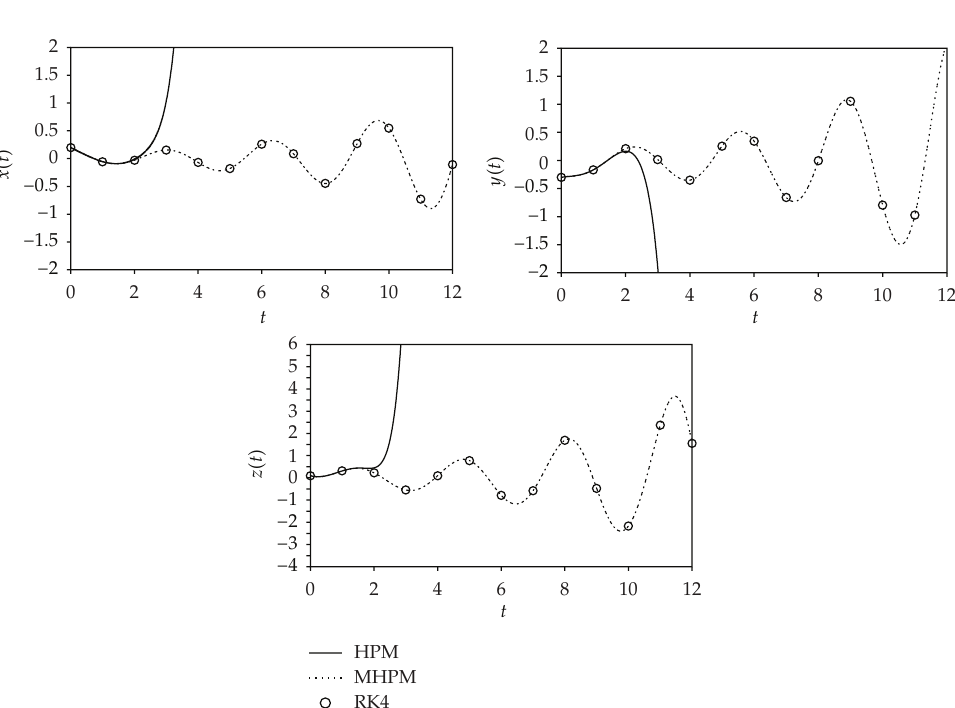
Figure 2: Graphical comparisons between HPM, MHPM (cid:3)Δ t (cid:8) 0 . 001 (cid:4) , and RK4 (cid:3)Δ t (cid:8) 0 . 001 (cid:4) for x (cid:3) t (cid:4) , y (cid:3) t (cid:4) , and z (cid:3) t (cid:4)